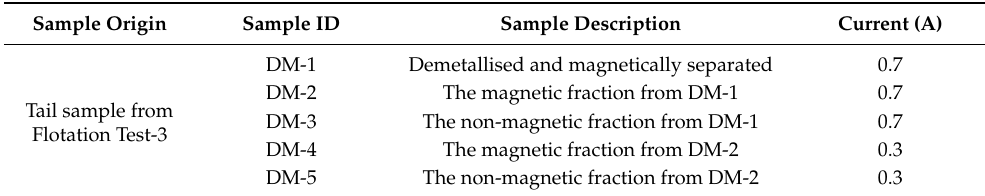
Table 3. Flotation test conditions and results